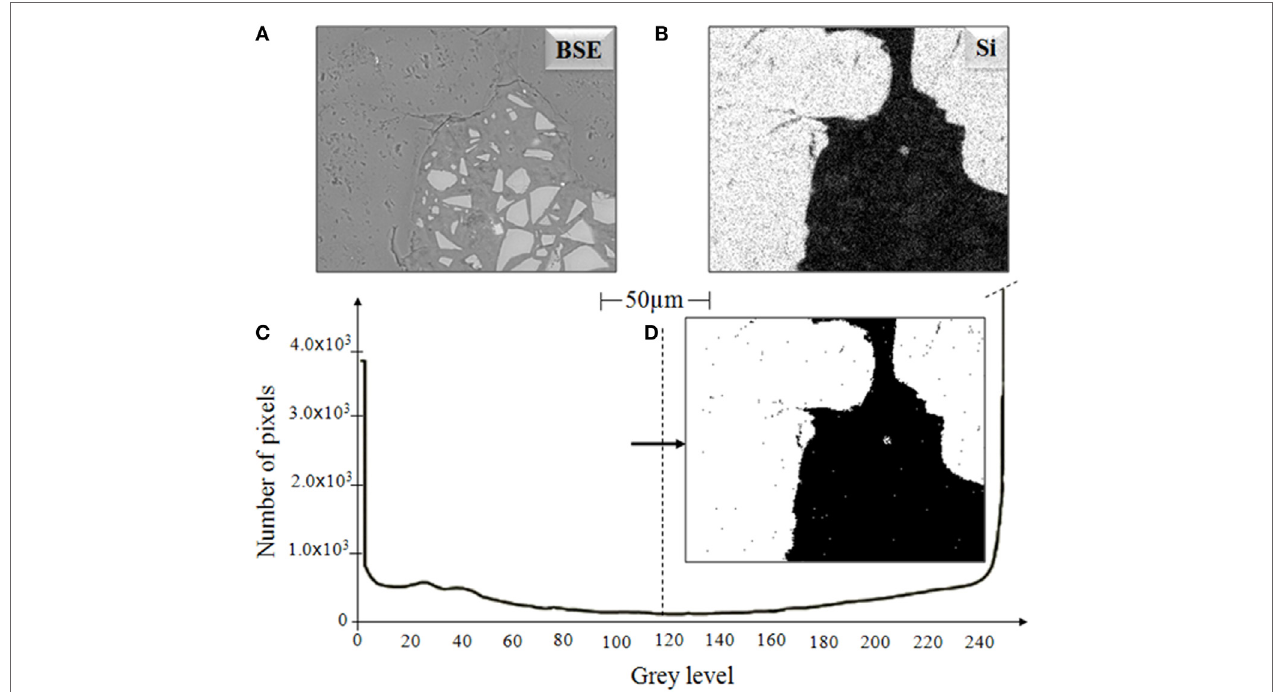
FigUre 2 | (a) BSE image of an AAS sample, (B) Si dot map, (c) histogram of (B) showing segmentation of aggregate, and (D) aggregate image obtained by thresholding of Si